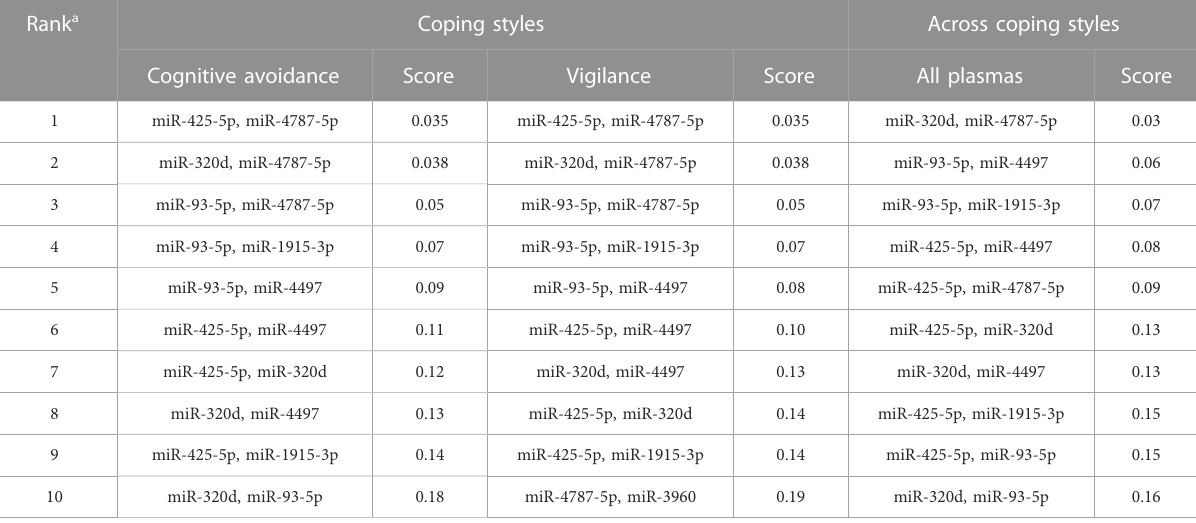
TABLE 4 Stability scores of miRNA reference gene pairs in plasma of male Caucasians differing in their mode of cognitive stress coping. Rank